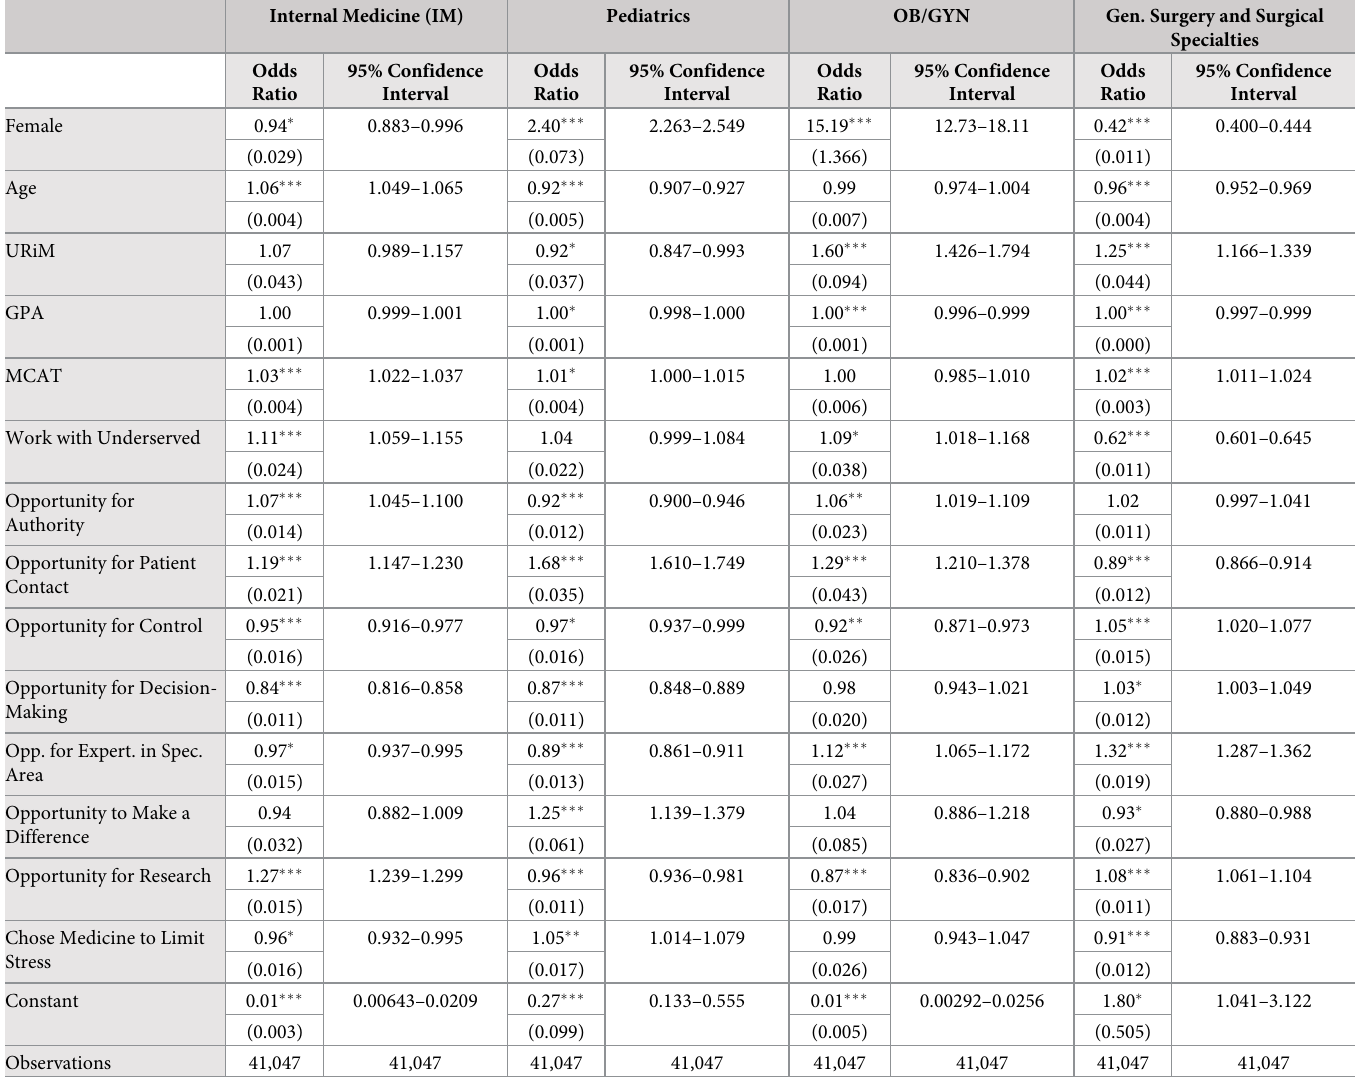
Table 2. Career interest when entering medical